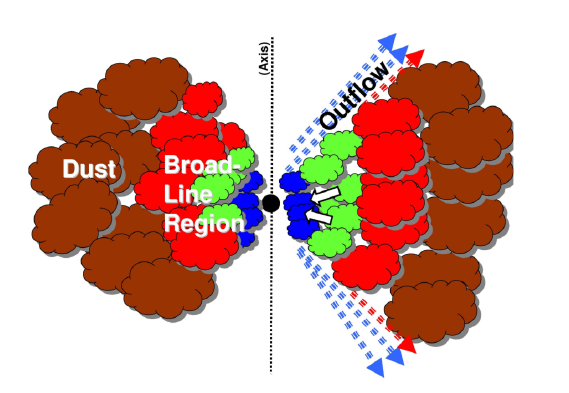
Fig. 1. A schematic view of the BLR and torus of an AGN in a plane through the axis. The figure is approximately to scale (except that the black hole is shown too large!). Figure from Gaskell, Goosmann & Klimek